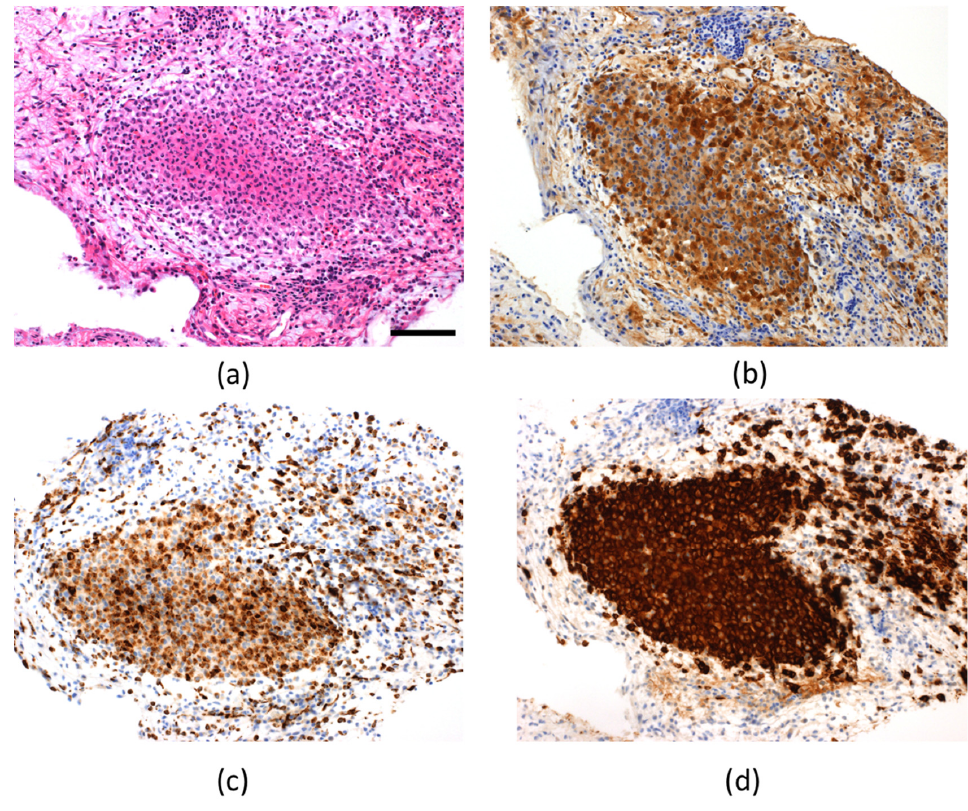
Figure 2. Histopathological examination of the pituitary stalk ( a ) Hematoxylin and eosin staining (scale bar; 100 µm); positive result of immunohistochemical analysis for S-100 ( b ), CD68 ( c ), and CD1a ( d ).